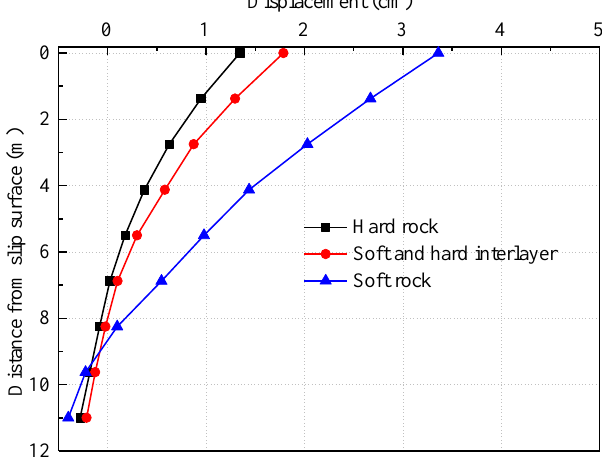
Figure 17. Displacement distributions along the embedded section of the stabilizing pile.